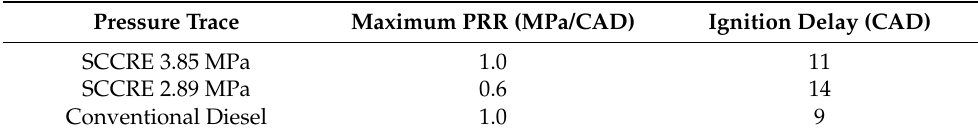
Table 1. Comparison of maximum PRR and ignition delay of the three pressure traces presented in Figure